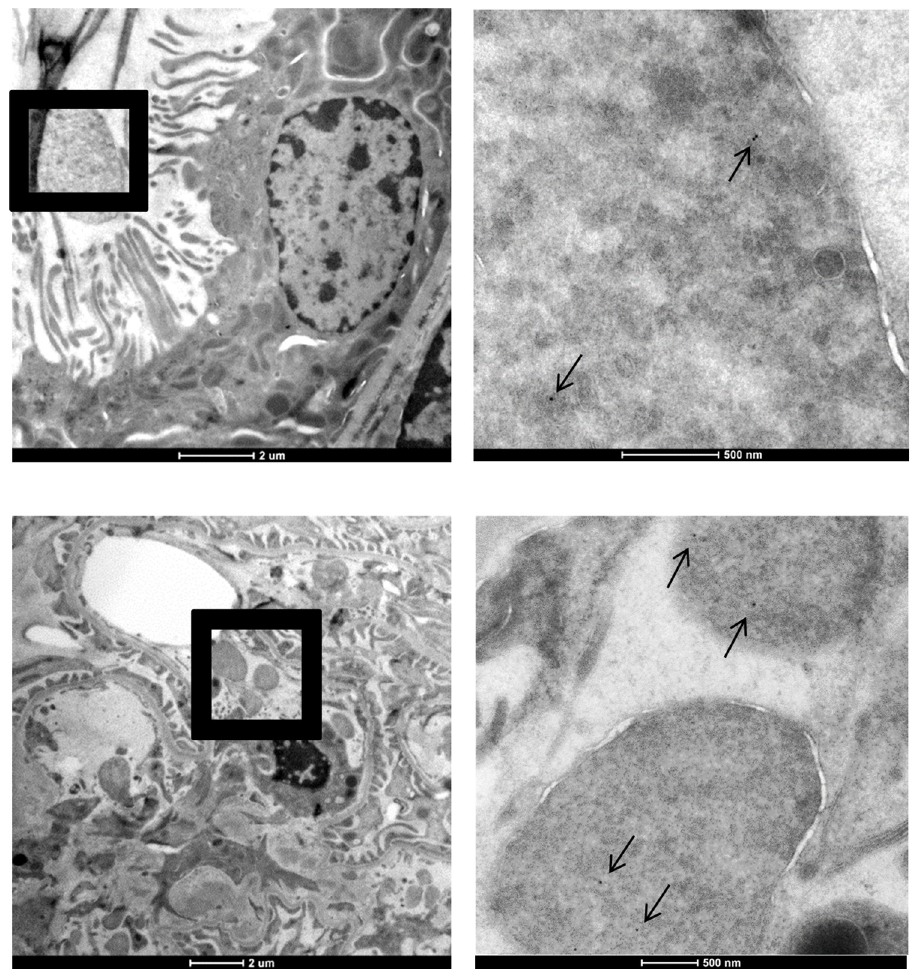
Fig 3. EM images of anti-histone H3 immunolabelling after 4 hours of warm ischemia in moderately damaged renal cells. Histone H3 (few gold particles indicated with black arrows) was scarcely detected by immuno-EM using antibody labelling with 10 nm gold particles. Top row: representative images are shown for histone H3 localization in a proximal tubule with histone localization in an ovoid cytoplasmic structure (left low magnification, right high magnification). Bottom row: extracellular histone H3 is present in ovoid and spheroid in glomerular endothelial cytoplasmic structures (left low magnification, right high magnification). Scale bar represents 2 μ m or 500 nm as